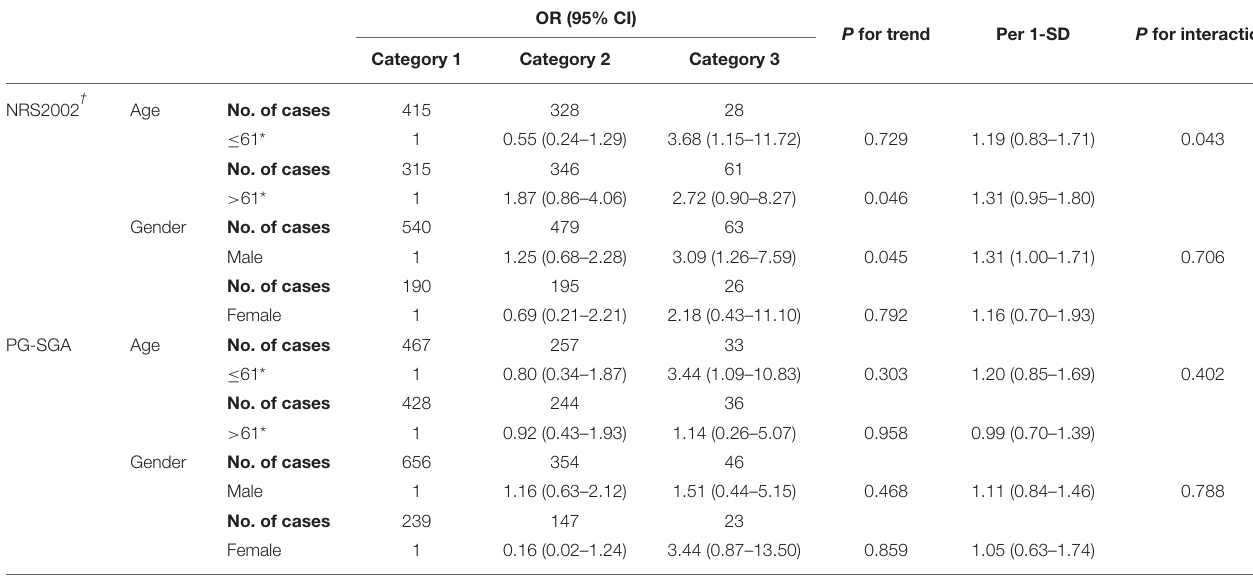
TABLE 4A | Stratified analysis of GC (age and gender).